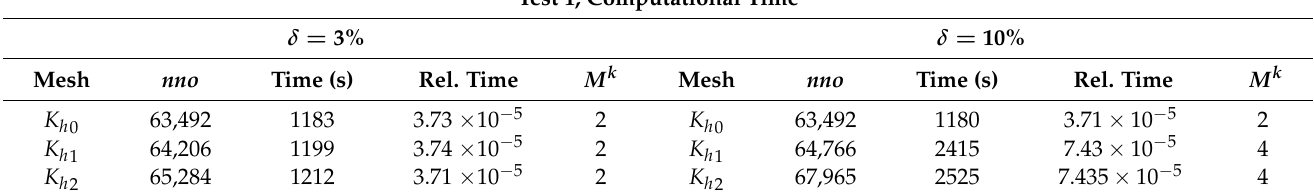
Table 5. Test 1. Performance of the reconstruction Algorithm 4 (in seconds) on adaptively refined meshes. Here, k is the number of the refined mesh K hk of the domain Ω FEM , nno is the number of nodes in the computational mesh K hk , and M k denotes the final number of iterations in the conjugate gradient Algorithm 3.